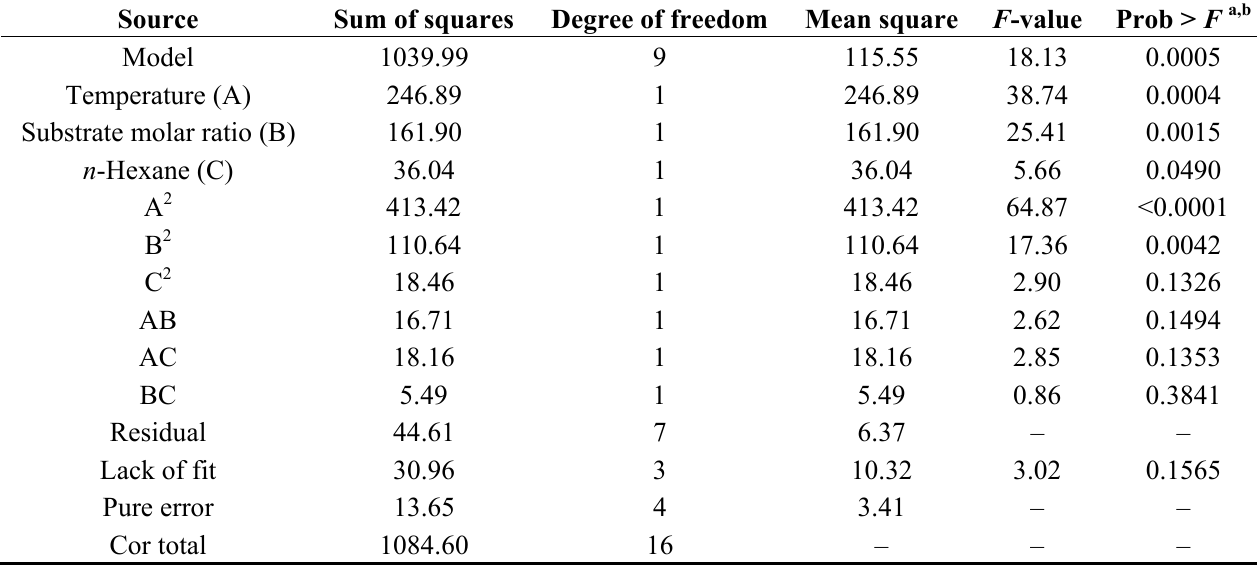
Table 2. ANOVA for joint test with soybean oil as a feedstock. Source